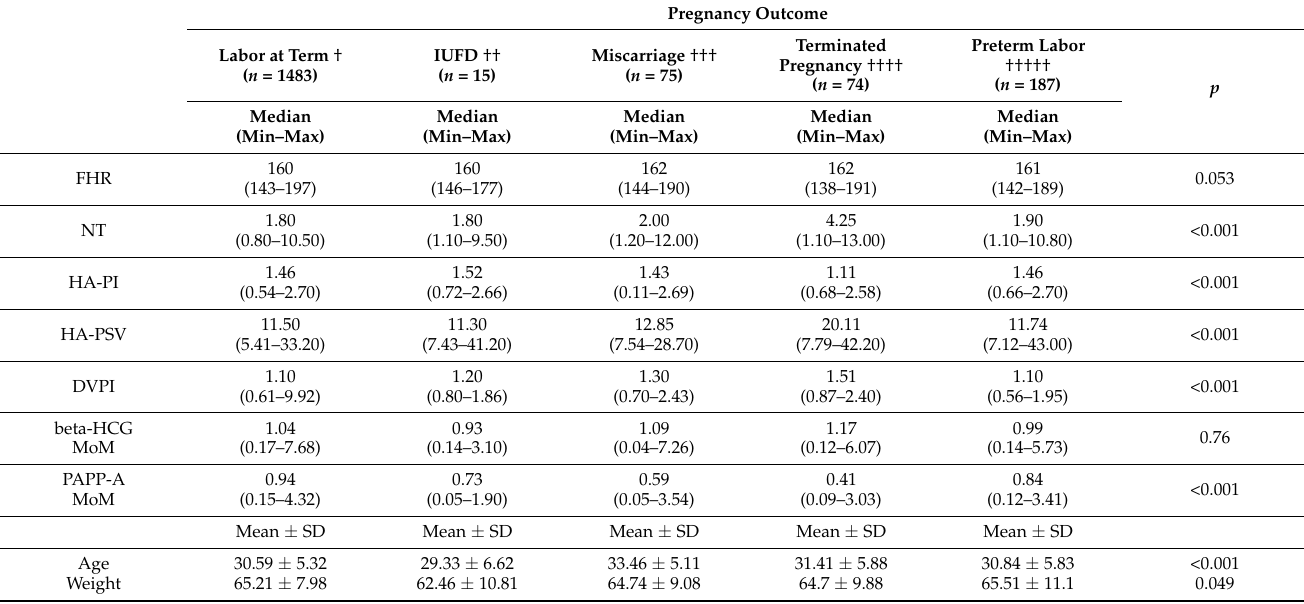
Table 5. Differences between selected first-trimester screening parameters depending on preg- nancy